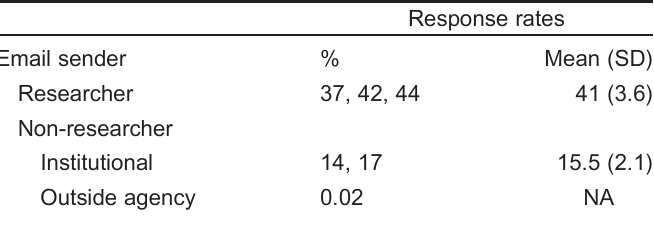
Table 3. Comparison of email sender and response